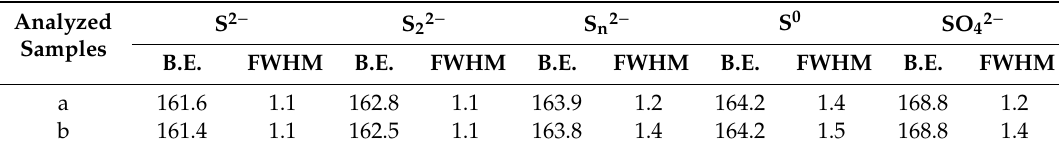
Figure 10. S 2p XPS spectra of leached pentlandite with di ff erent conditions: ( a ) pH = 2.00, leached for 16 days; ( b ) pH = 3.00, leached for 16 days. Table 2. Binding energy and full width at half maxima of sulfur specie in XPS profiles.